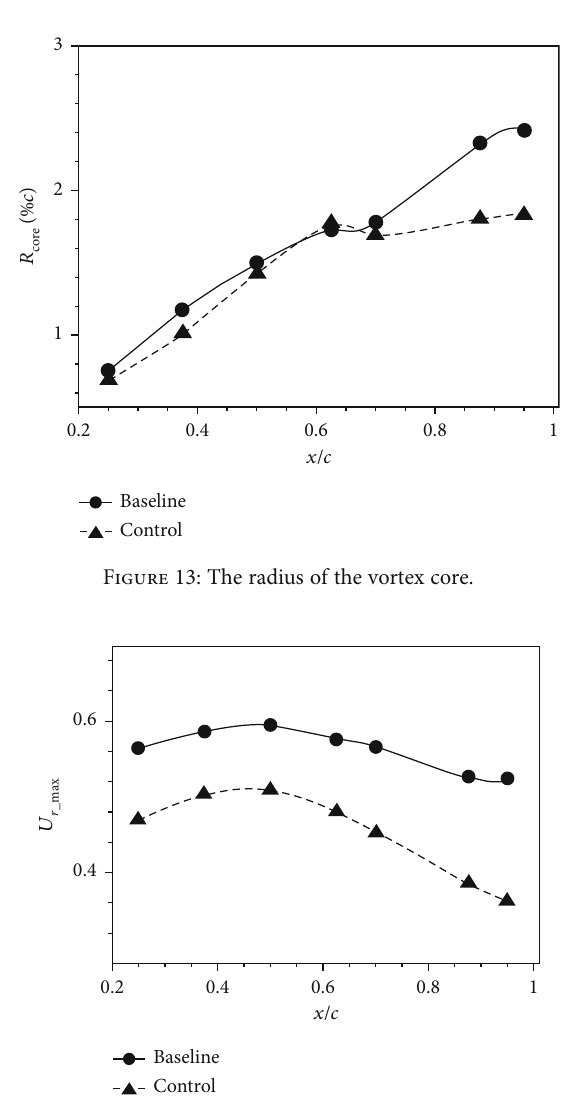
Figure 14: The axial vorticity fl ux of the vortex core.